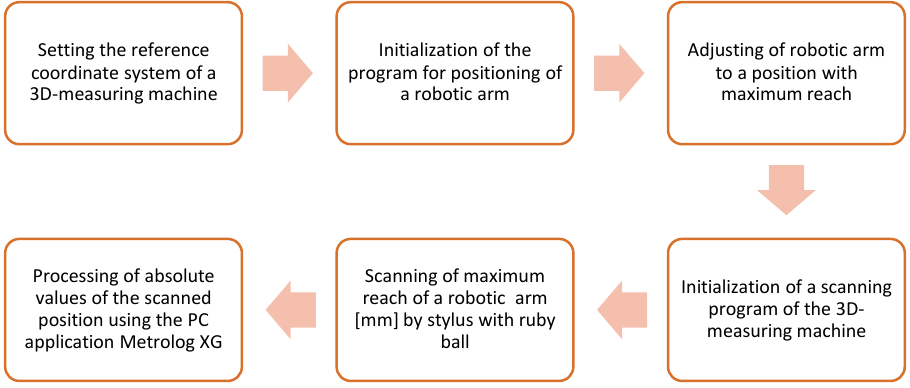
Figure 5. Measuring chain for CoM of robotic arm’s position .